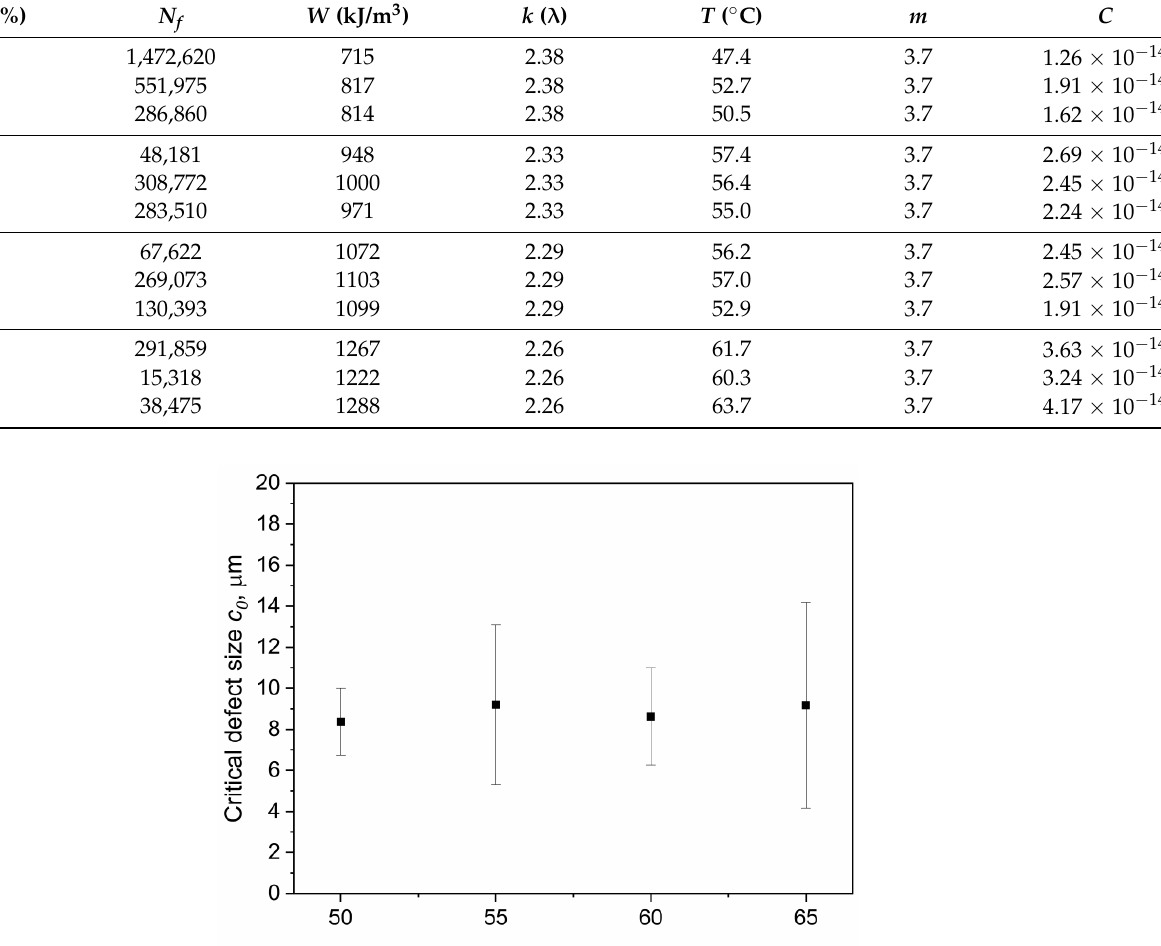
Table 1. Overview of the values used to calculate the critical defect size with the reversion of Equation (10). The values of the number of cycles to failure are the same as reported in Figure 3.